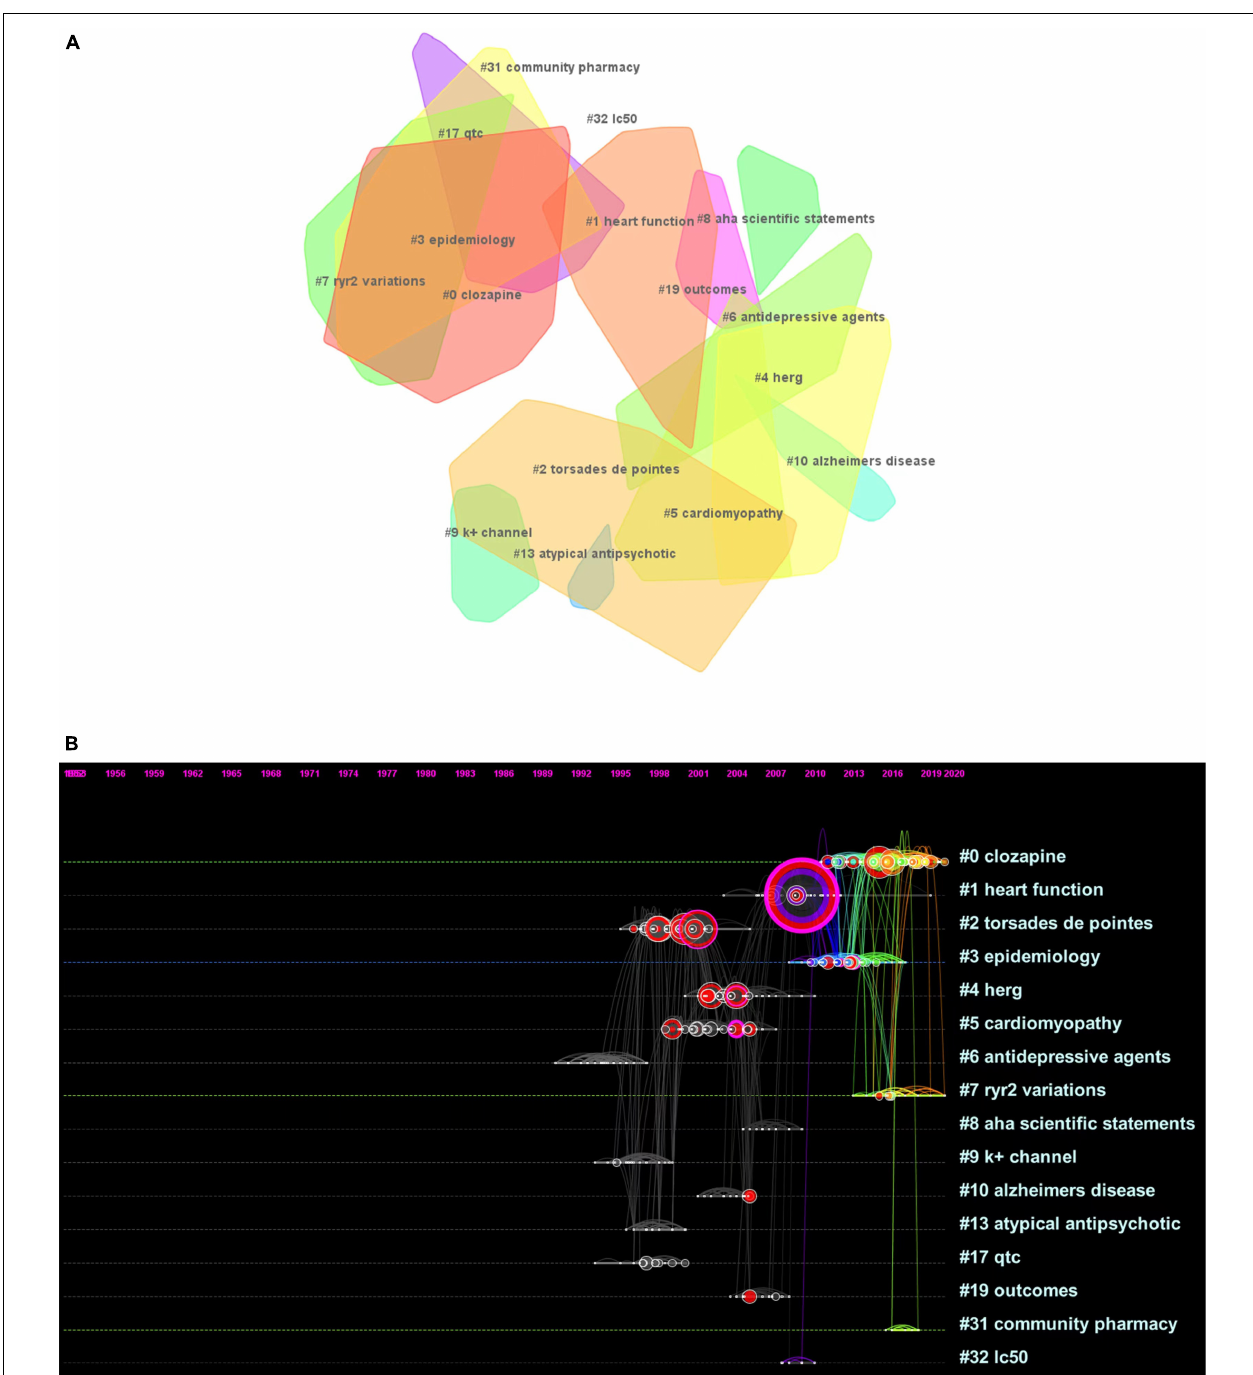
FIGURE 4 | (A) Landscape view of the co-citation network. All cluster labels were extracted from titles of citing articles using the log-likelihood ratio algorithm. (B) Timelines of co-citation clusters. Major clusters are labeled on the right.